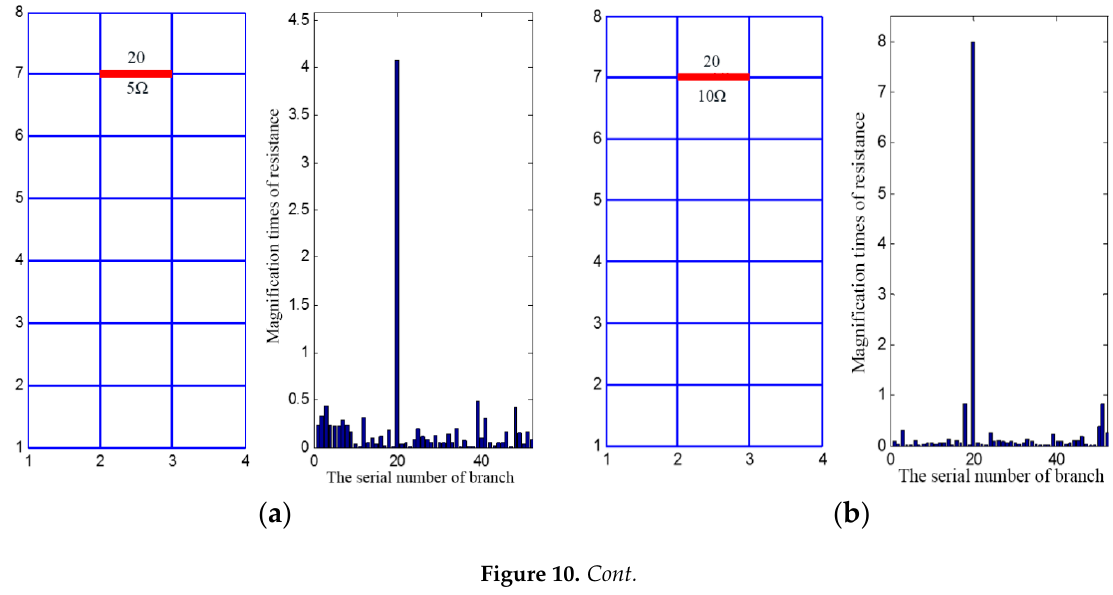
Figure 9. The schematic and actual diagrams of the model made by precise resistors.